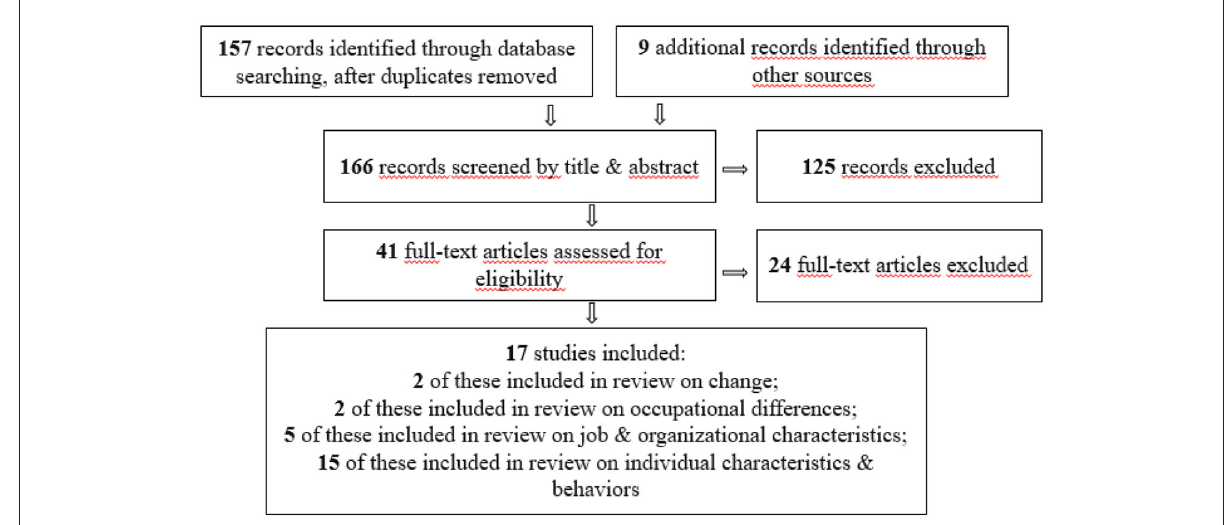
FIGURE1 Literature search process with numbers of articles considered. When screening records by title and abstract, most of the records excluded did either not focus on K − 12 teachers, did not apply a quantitative research design or were not written in English. Most of the full-text articles excluded had either not measured teacher burnout or stress or had not sampled K − 12